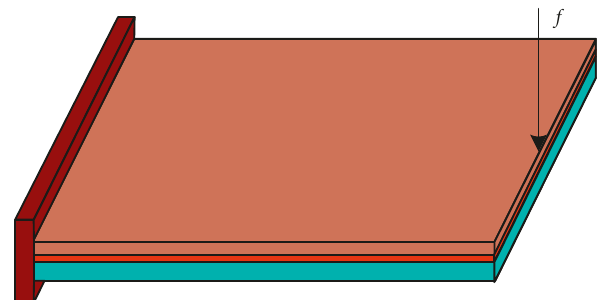
Figure 2: The cantilever plate/CLD